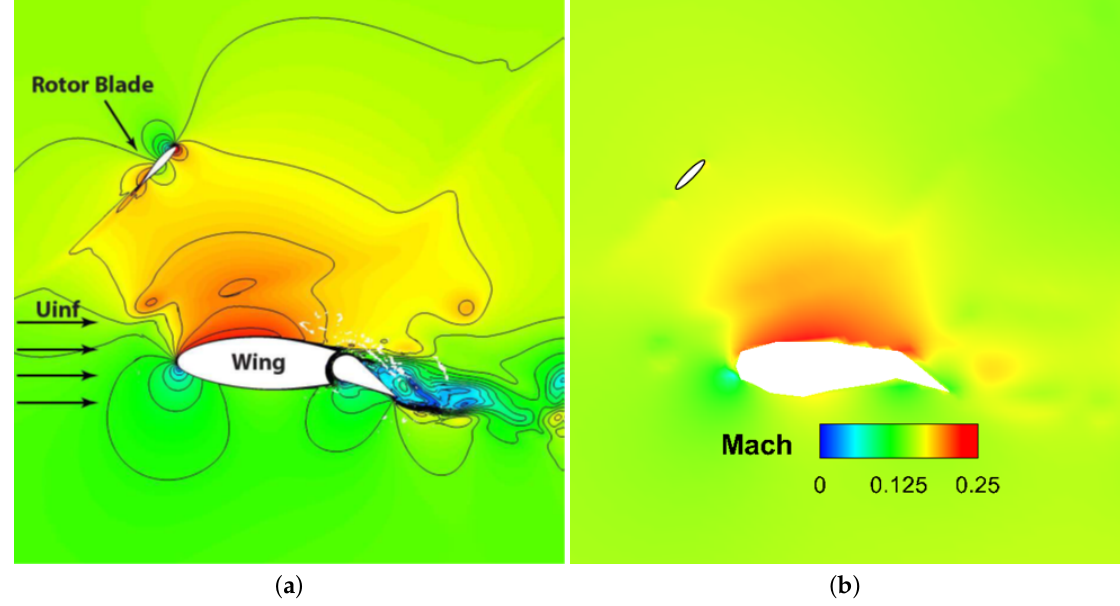
Figure 20. Comparison of the instantaneous flow field at wing midspan in conversion flight condition at ψ = 270 ◦ , θ N = 60 ◦ , V ∞ = 100 kts, Ω = 589 RPM. ( a ) CFD-[16]; ( b )